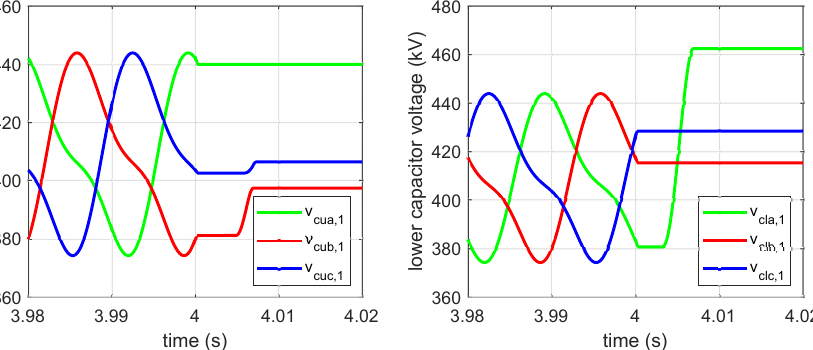
Figure 16. Capacitors voltages during DC pole-to-pole fault with DC circuit-breakers v cu , i ( t ) / v cl , i ( t ) , i ∈ { a ; b ; c } , green for phase a, red for phase b and blue for phase